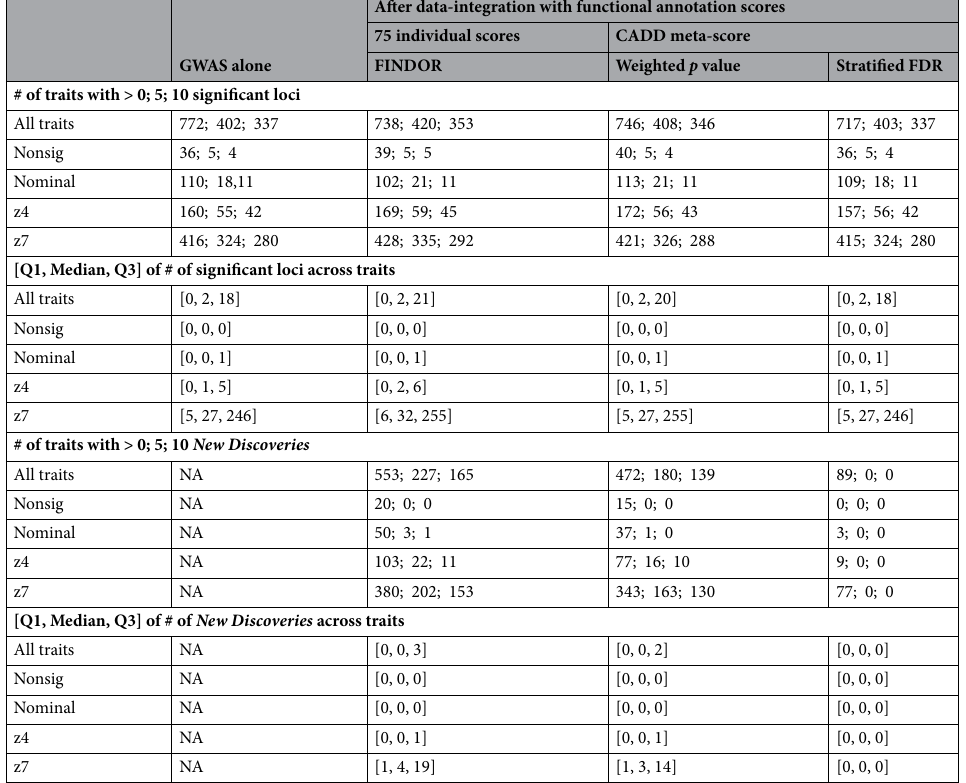
Table 1. Results of the UK Biobank application study, before and after data-integration with functional annotations, stratified by the four phenotype categories. The three data-integration methods integrated the UK Biobank GWAS summary statistics with functional annotations using FINDOR (using 75 individual annotation scores), and the weighted p value andstratified FDR control methods (each using the Eigen meta-score), analyzing 7,895,174 variants for each of the 1132 UK Biobank traits. The 1132 traits were rated by Nealelab having medium to high confidence for their heritability estimates, and they fall into four categories: nonsig (182 traits; heritability testing p > 0.05 ), nominal (277 traits; p < 0.05 ), z4 (235 traits; p <